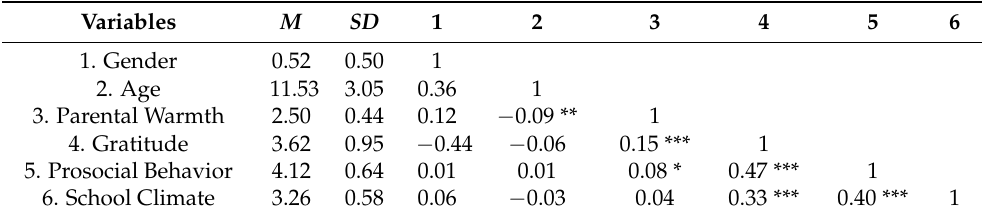
Table 1. Descriptive statistics and correlations for all